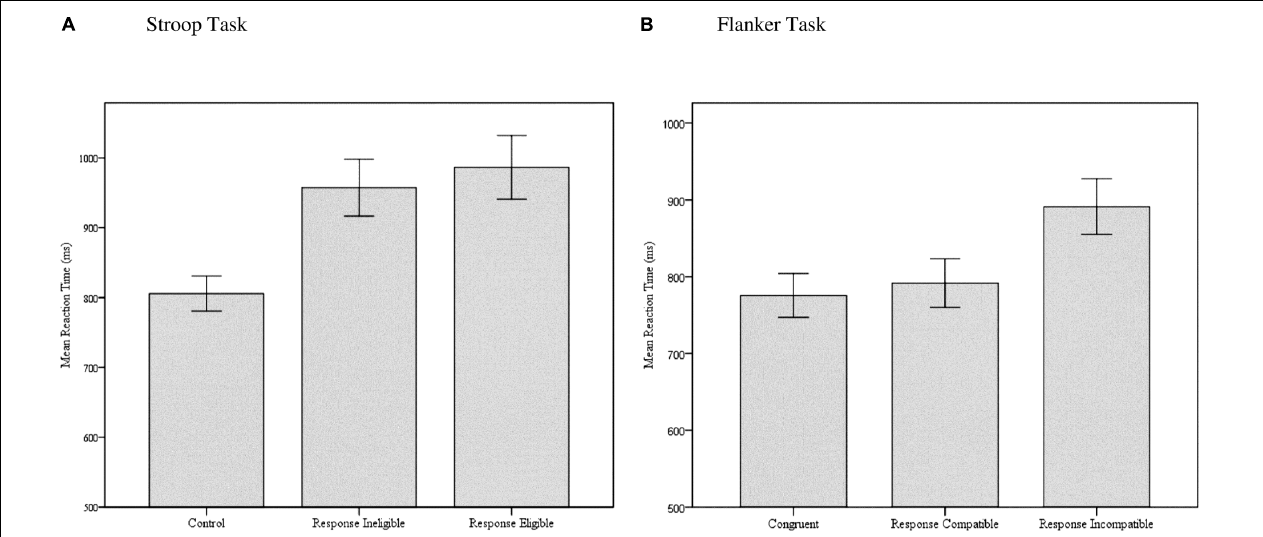
FIGURE 5 | Bar graphs of mean reaction times on the (A) Stroop and (B) Flanker task for the different task conditions, demonstrating the relative contribution of SS-conflict and SR-conflict to the overall interference effect. Error bars represent 95% confidence intervals.